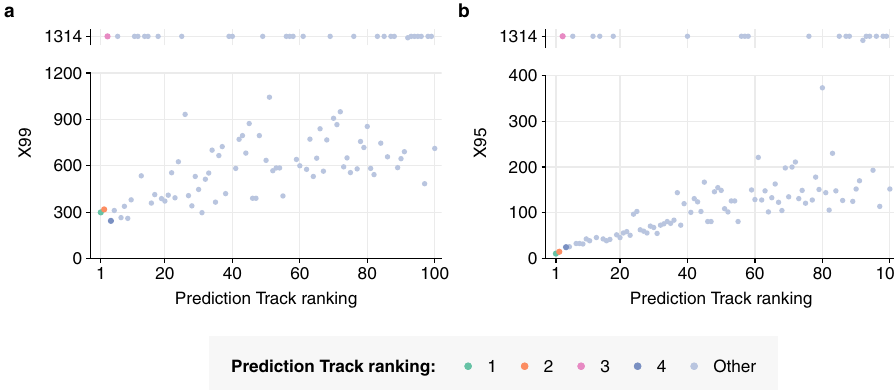
Fig. 4 | X-metrics in detail. a X99 and ( b ) X95 scores achieved by each of the top 100 Prediction Track teams, on separate linear scales. In each case, outlier values are shown in a separate panel above. There are 1314 lab categories in the